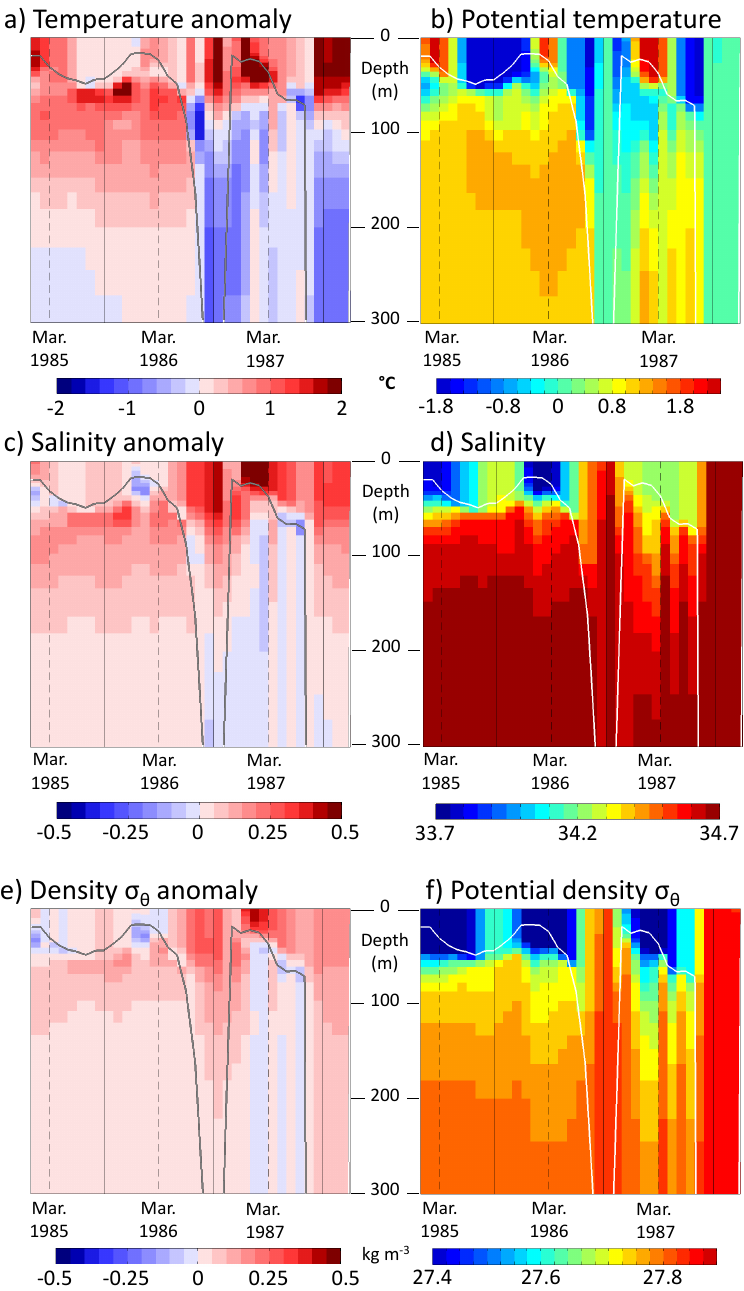
Figure 3. Hovmoller diagrams, as a function of depth and time, of properties averaged over the area of the 1986 polynya (dashed black contour on Fig. 2e) until August 1986, along the trajectory of Fig. 2e from September 1986 to June 1987, and over the area of the 1987 polynya (plain black contour on Fig. 2e) from July 1987: (a) potential temperature anomalies (relative to January 1980–December 1984), (b) potential temperature, (c) salinity anomaly (relative to January 1980–December 1984), (d) salinity, (e) potential density σ θ anomaly (relative to January 1980–December 1984), and (f) potential density σ θ . Grey line on (a) , (c) and (e) and white line on (b) , (d) and (f) is the